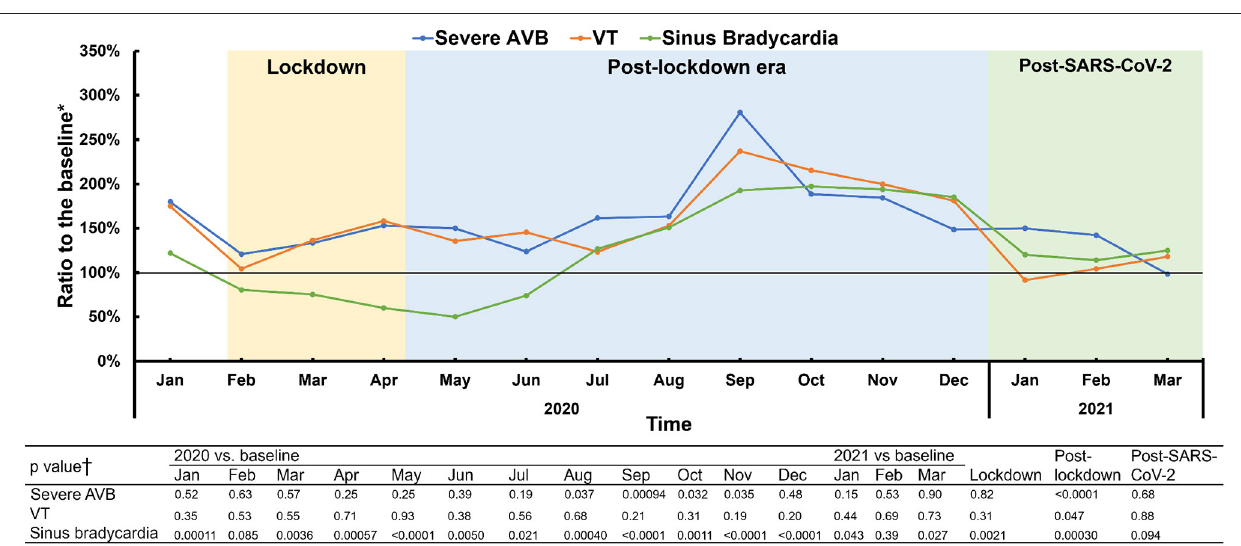
FIGURE 5 | Different patterns of dynamics in disease-specific medical visits, represented by severe AVB, VT and sinus bradycardia. Three patterns of disease-specific medical visits dynamics during and following the pandemic were noticed, according to the ratio to the medical visits of the pre-COVID period. Pattern 1 (stable-increase-stable pattern) is represented by severe AVB. Pattern 2 (stable-stable-stable) is represented by ventricular tachycardia. Pattern 3 (decrease-rebound-fallback) is represented by sinus bradycardia. *Baseline was determined by the average number from 2018 and 2019. † The comparisons were obtained by a Mann-Whitney test. AVB, atrioventricular block; VT, ventricular tachycardia. The severe AVB includes second-degree type 2, high-degree and third-degree